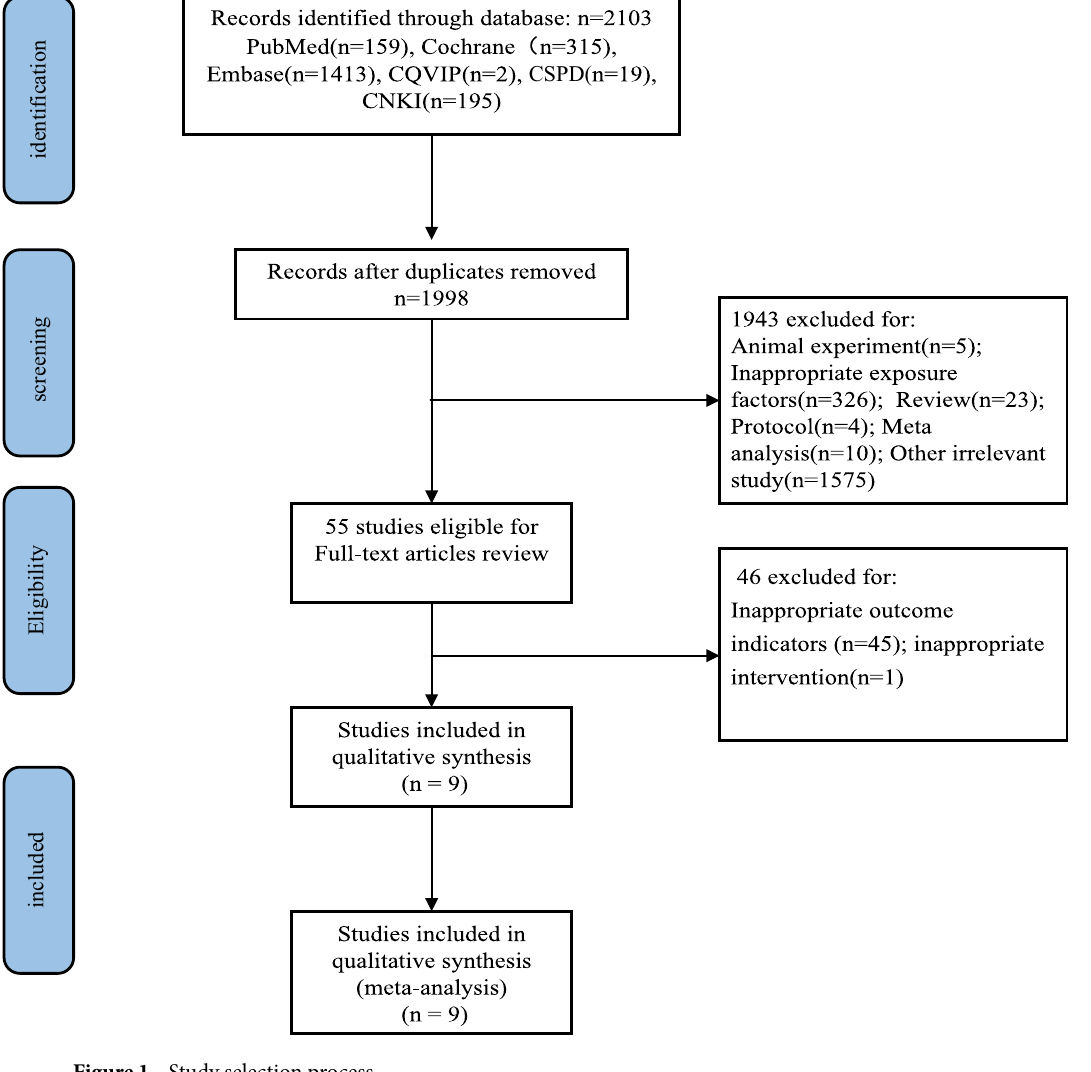
Figure 1. Study selection